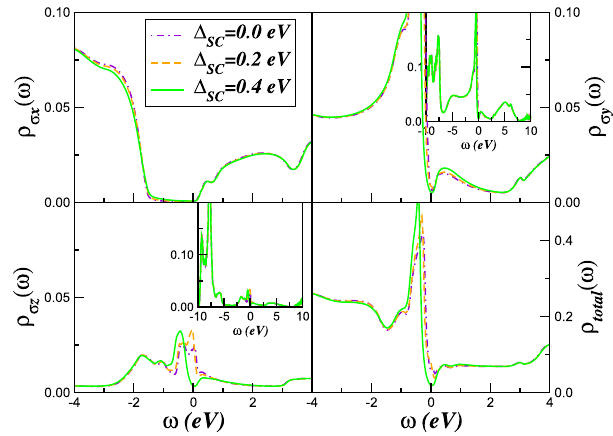
Figure 7. Orbital resolved and total LDA + DMFT density-of-states (DOS) in the normal ( Δ SC = 0) and supercoducting state ∆ ≠ ( 0) of solid O 2 . Here, the normal state LDA + DMFT solution for Δ = 0.4 eV is used SC as starting point towards understanging the selective modification of the excitation spectrum within the superconducting state. Notice the evolution of the superconducting gap at low energies in the electronic DOS of the p y and p z